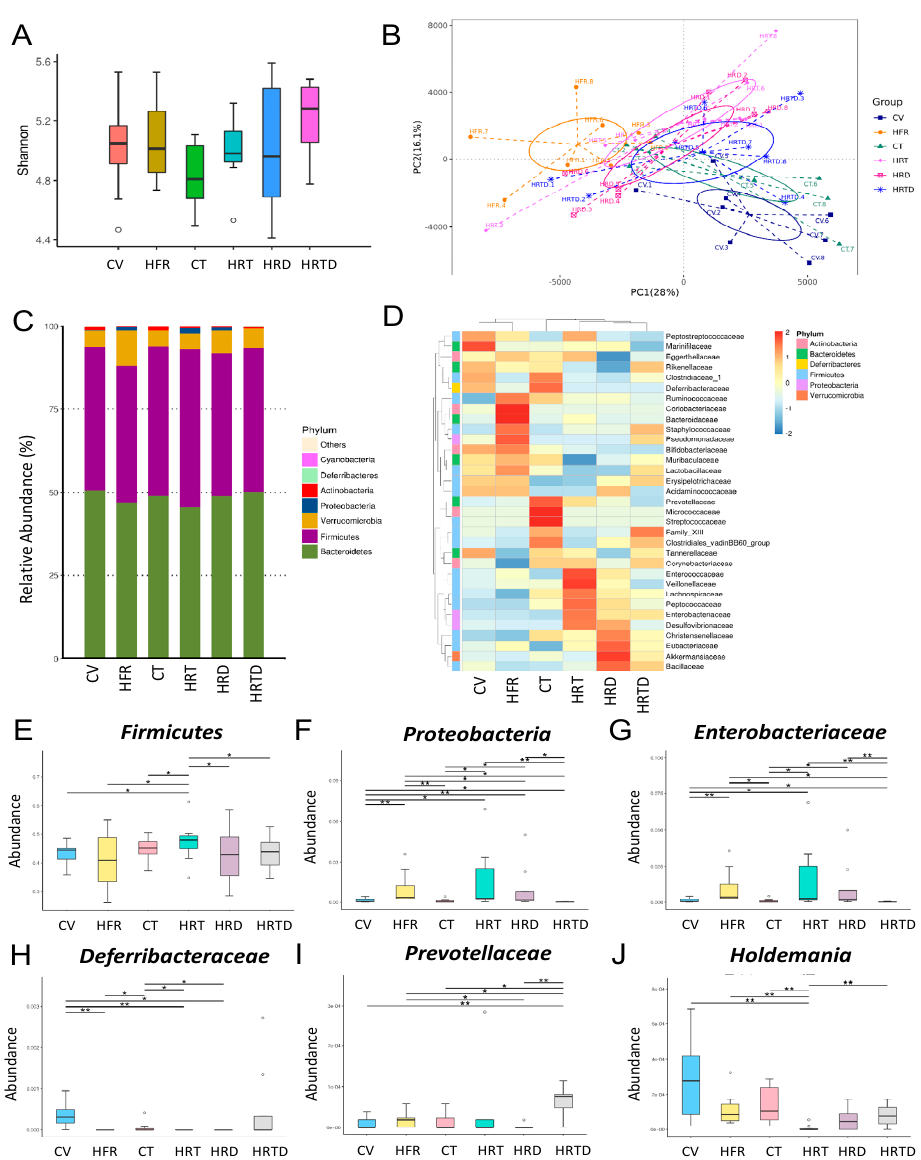
Figure 4. Effects of high-fructose intake, 2,3,7,8-tetrachlorodibenzo-p-dioxin (TCDD) exposure, and 3,3-dimethyl-1-butanol (DMB) on the gut microbiota in offspring at 3 weeks of age. ( A ) α -diversity was represented by the Shannon’s indexes. ( B ) β -diversity changes in gut microbiota across groups were shown by principal component analysis (PCA). ( C ) Relative abundance of the top 10 phyla of the gut microbiota among the six groups. ( D ) Heat map of the 16S rRNA gene sequencing analysis of the gut microbiome at the family level. The abundance of ( E ) phylum Firmicutes , ( F ) phylum Proteobacteria , ( G ) family Enterobacteriaceae , ( H ) family Deferribacteraceae , ( I ) family Prevotellaceae , and ( J ) genus Holdemania among the six groups. CV = control rat received regular diet and vehicle; HFR = rats received high-fructose diet; CT = rats received regular diet and TCDD exposure; HRT = rats received high-fructose diet and TCDD exposure; HRD = rats received high-fructose diet and DMB treatment; HRDT = rats received high-fructose diet, TCDD exposure, and DMB treatment. * p < 0.05. ** p < 0.01.